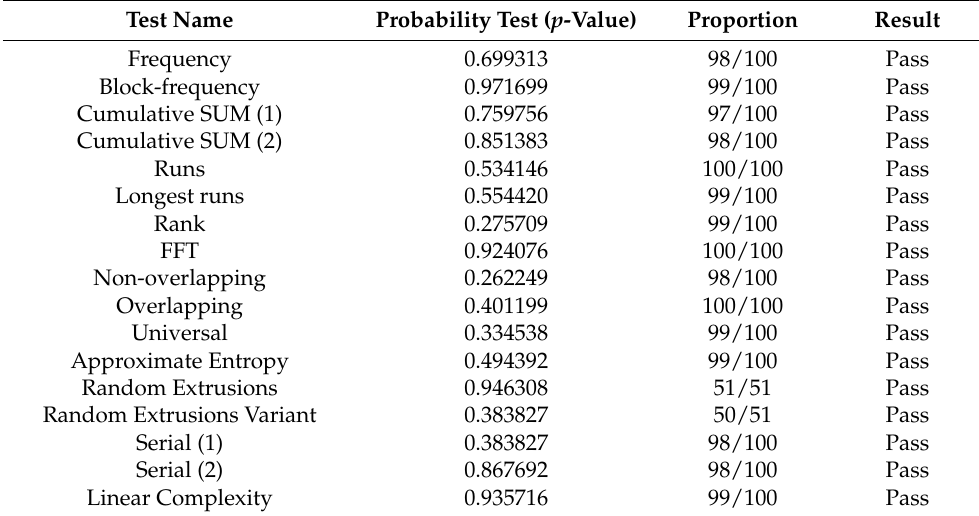
Table 6. NIST test